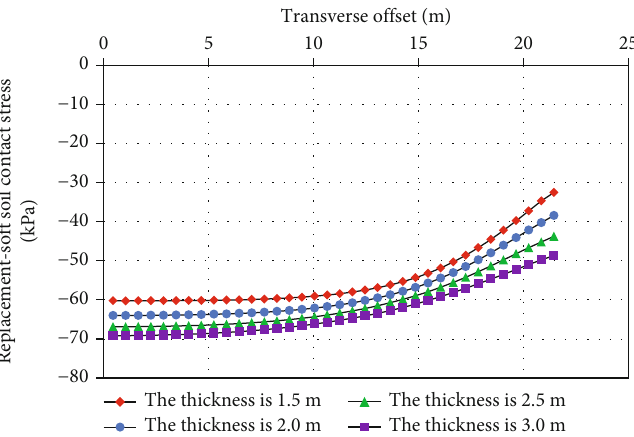
Figure 10: Transverse distribution of replacement-soft soil contact stress with di ff erent thicknesses of replacement.